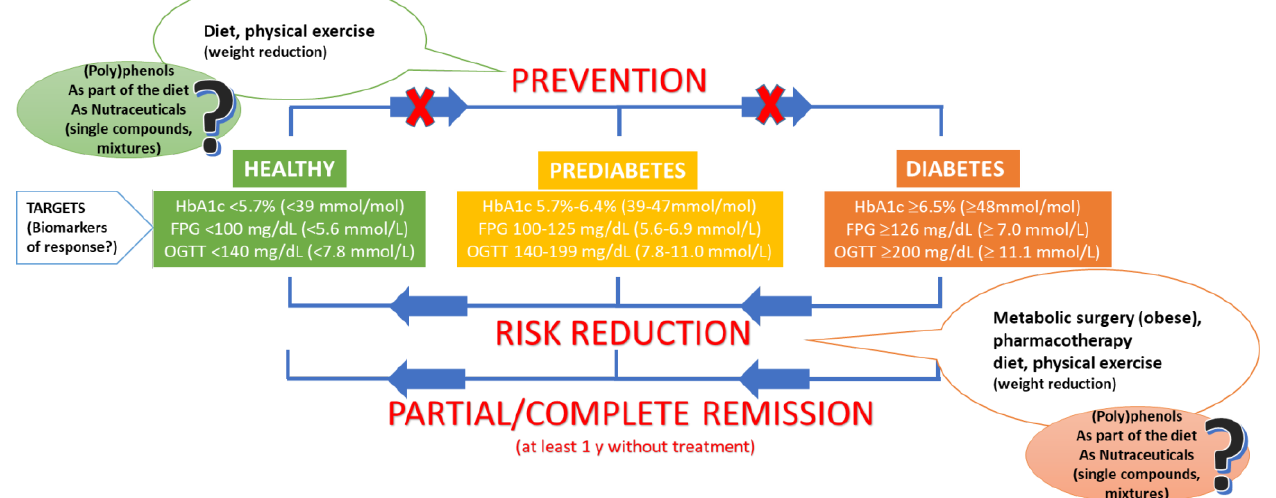
Figure 1. Summary graphics representing the current criteria for the screening and diagnosis of prediabetes and diabetes as well as the main means to combat this disorder. (Poly)phenols may be used both as dietary or nutraceutical compounds for the prevention and (or) treatment of the dis- ease.